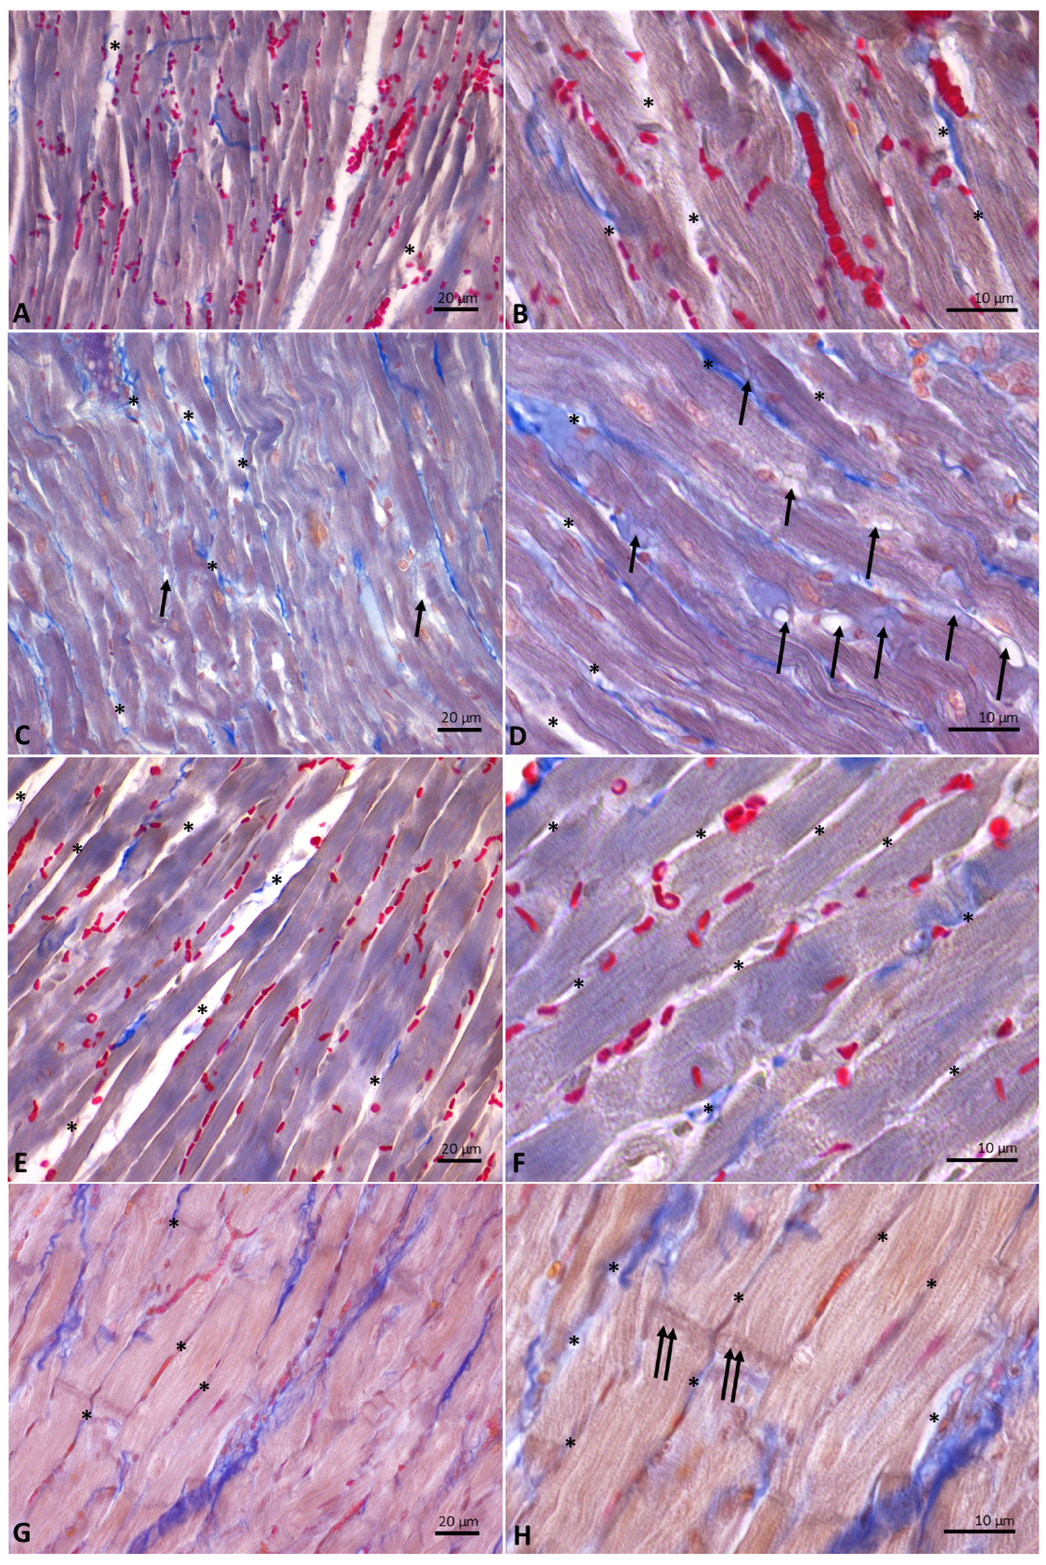
Figure 6. Longitudinal sections of rat hearts stained with Mallory’s trichrome stain. ( A , B ): controls. ( C , D ): donkey milk (DM) diet supplementation. ( E , F ): human milk (HM) diet supplementation. ( G , H ): cow milk (CM) diet supplementation. Legends: arrow, adipocyte; asterisk, intercellular space, double arrow, intercalated discs. Scale bar: ( A , C , E , G ), 20 µm; ( B , D , F , H ), 10 µm.